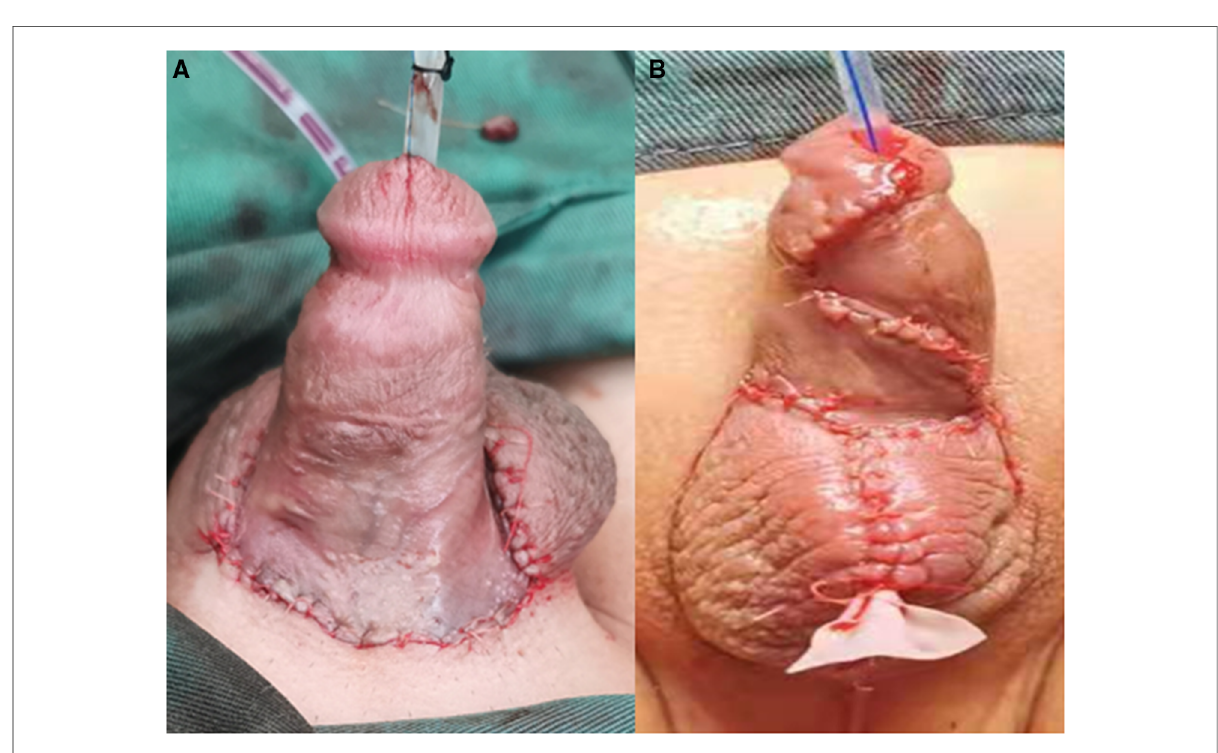
FIGURE 4 Reconstruction of penis and scrotum with fl ap transfer. ( A ) Dorsal view; ( B ) Ventral